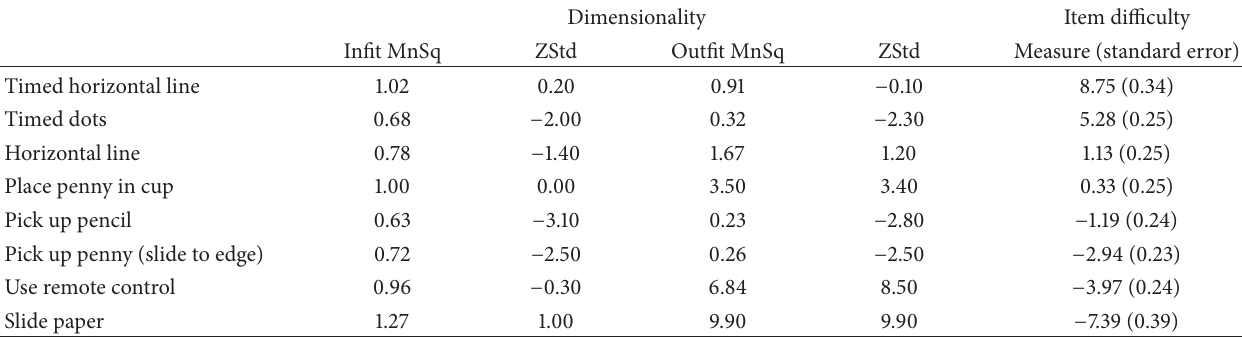
Table 6: Behavioral criteria statistics for short form of hand activities item.